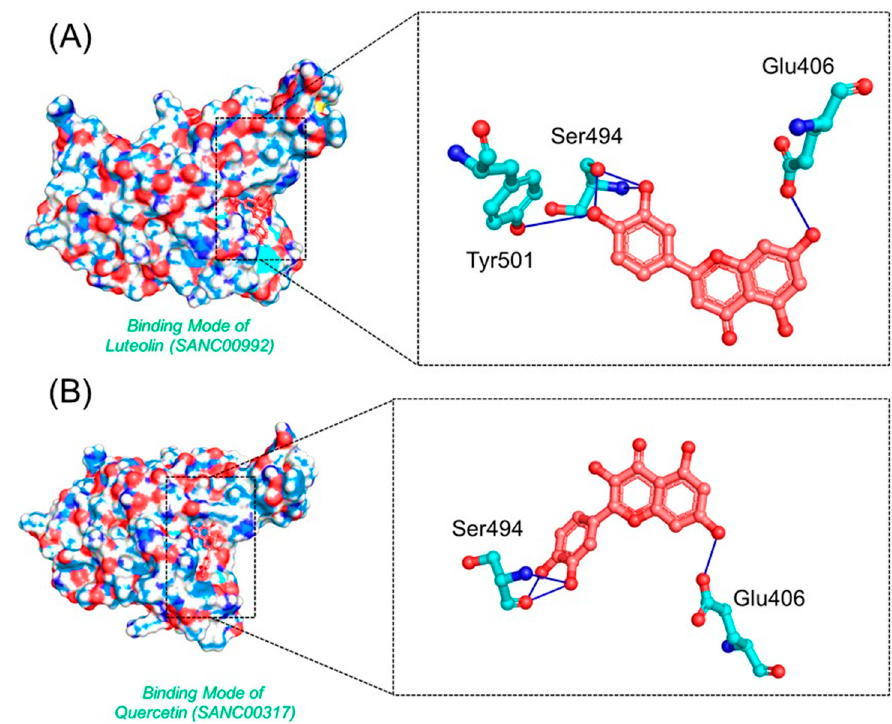
Figure 5. The interaction patterns of Luteolin (SANC00992) and Quercetin (SANC00317) : ( A ) the binding of Luteolin (SANC00992); ( B ) the 3-dimensional interaction pattern of Quercetin (SANC00317) .